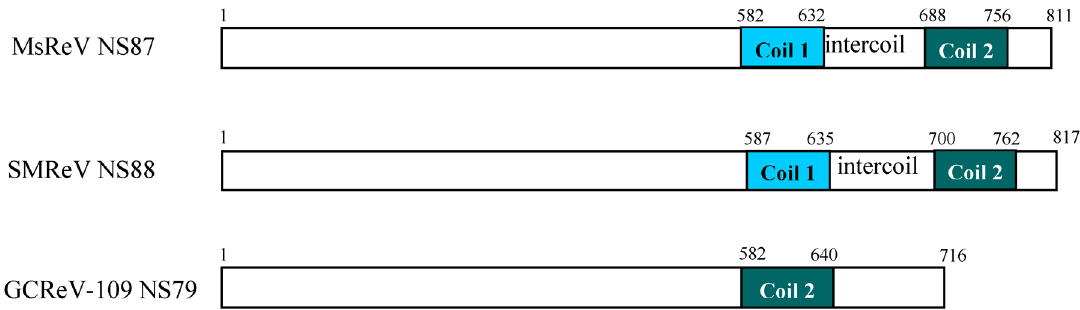
Figure 2. Diagram of predicted coil regions in the nonstructural proteins encoded by S4 segments among MsReV, SMReV and GCReV-109. MsReV NS87 and SMReV NS88 have